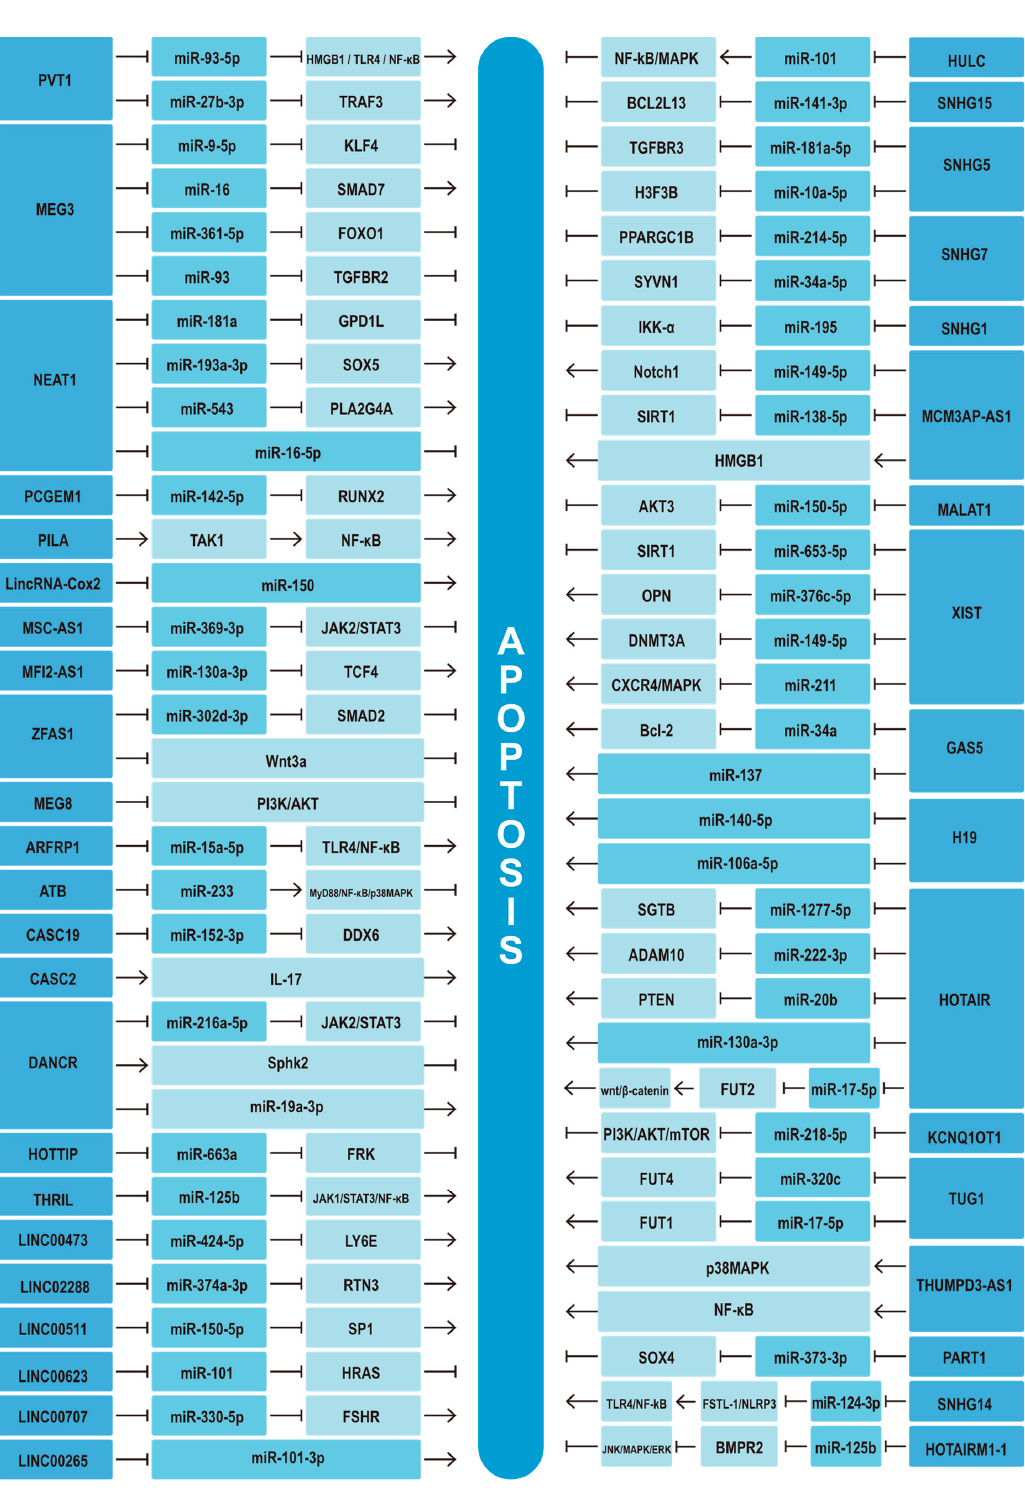
Figure 4. Schematic representation of the signaling pathways involved in this review for the regulation of apoptosis by lncRNAs. Different shades of color represent different molecules. The earliest identified lncRNAs, XIST and H19, can influence OA processes through multiple pathways. In addition to modulating inflammatory responses, Liu et